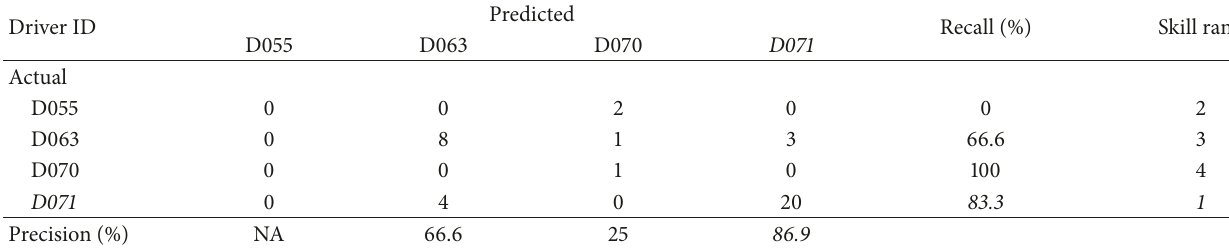
Table 11: Confusion matrix on group 9 (G9) of drivers.